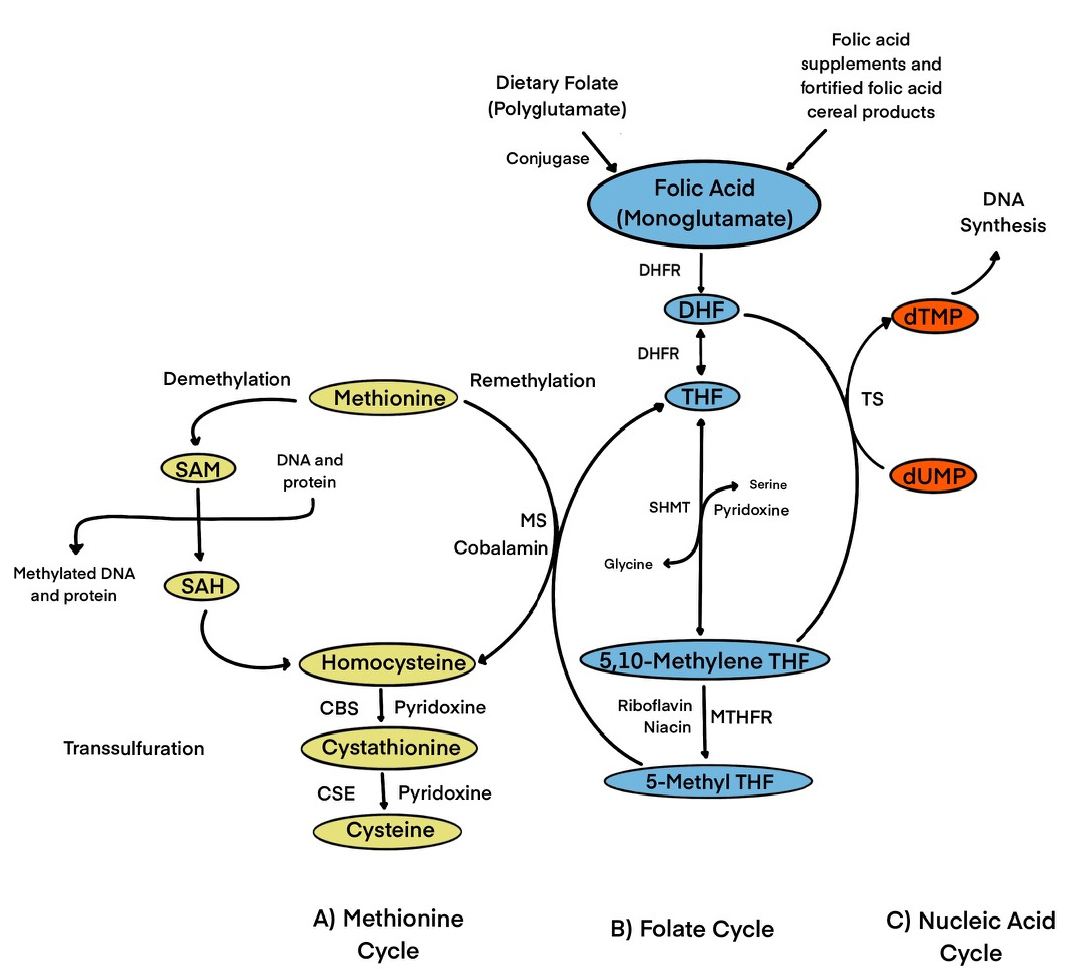
Figure 1. Role of folate in one-carbon transfer metabolism. Folic acid from dietary folate or folic acid from fortified foods/supplements is reduced to DHF and then to THF by DHFR. SHMT converts THF to 5,10-methylene THF. 5,10-methylene-THF is reduced by MTHFR to 5-methyl-THF. 5-methyl THF is catalyzed by MS to generate THF and methionine through the remethylation of Hcy. Cobalamin is a cofactor for MS. Methionine is then used to form SAM, which serves as a universal methyl donor for numerous reactions and produces SAH, which then generates homocysteine. Hcy is then used either to regenerate methionine, or it is converted to β -cystathionine and then to cysteine in the transsulfuration pathway. In the regeneration of DHF from 5,10-methylene THF, dUMP is converted to dTMP by TS which can be used for DNA synthesis. Abbreviations: CBS, cystathionine- β synthase; CSE, Cystahionine- γ lyase; DHF, dihydrofolate; DHFR, dihydrofolate reductase; dTMP, deoxythymidine monophosphate; dUMP, deoxyuridine monophosphate; MS, methionine synthase; MTHFR, methylenetetrahydrofolate reductase; SAH, S-adenosylhomocysteine; SAM, S-adenosylmethionine; SHMT, serine hydroxymethyltransferase; THF, tetrahydrofolate; TS, thymidylate synthase.